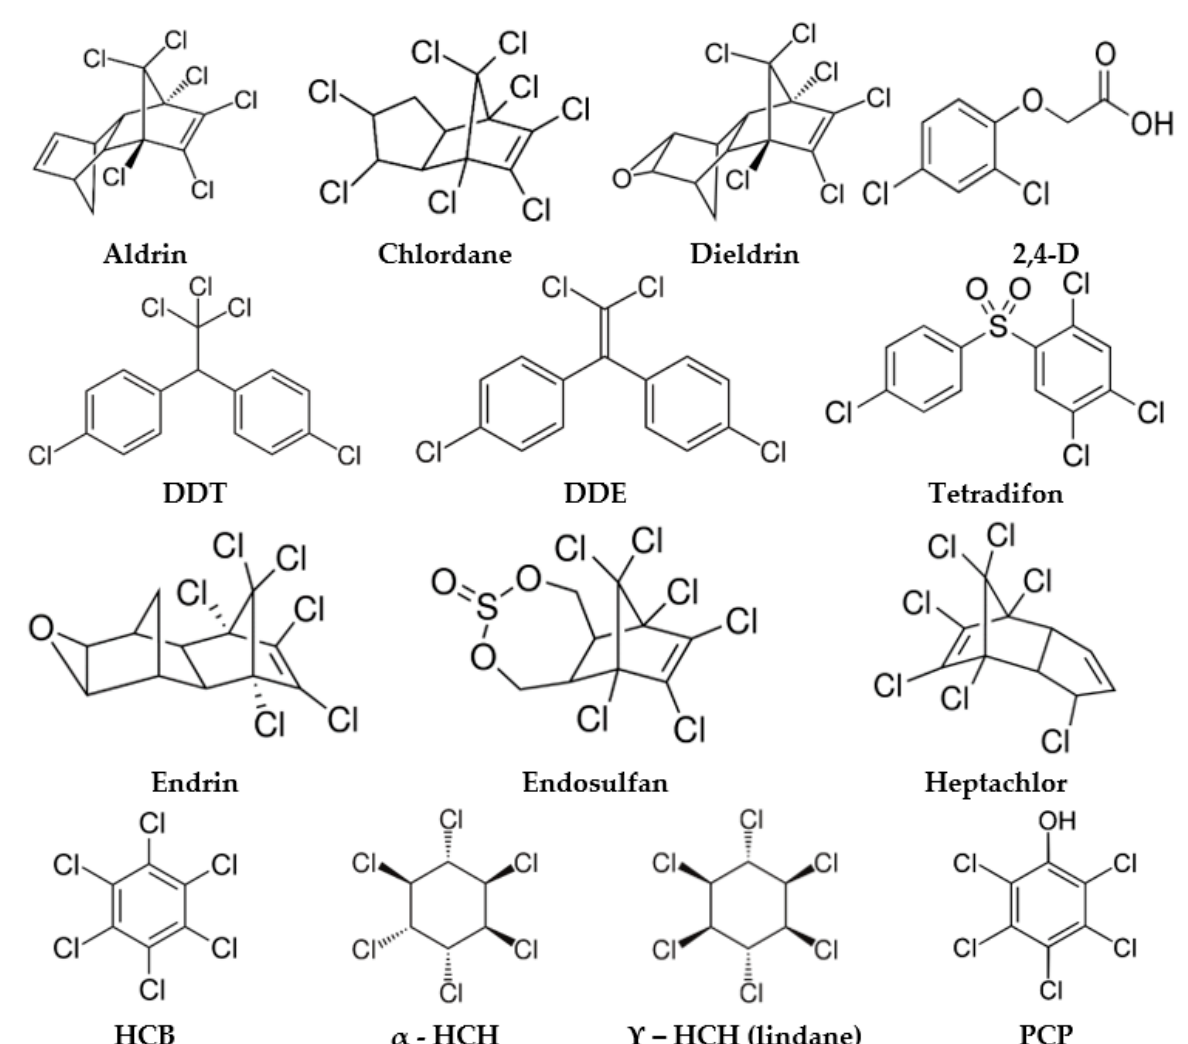
Figure 1. Structures of the listed organochlorine pesticides. DDE—dichloro-diphenyl-dichloro-ethylene; 2,4-D—2,4-dichloro-phenoxyacetic acid.